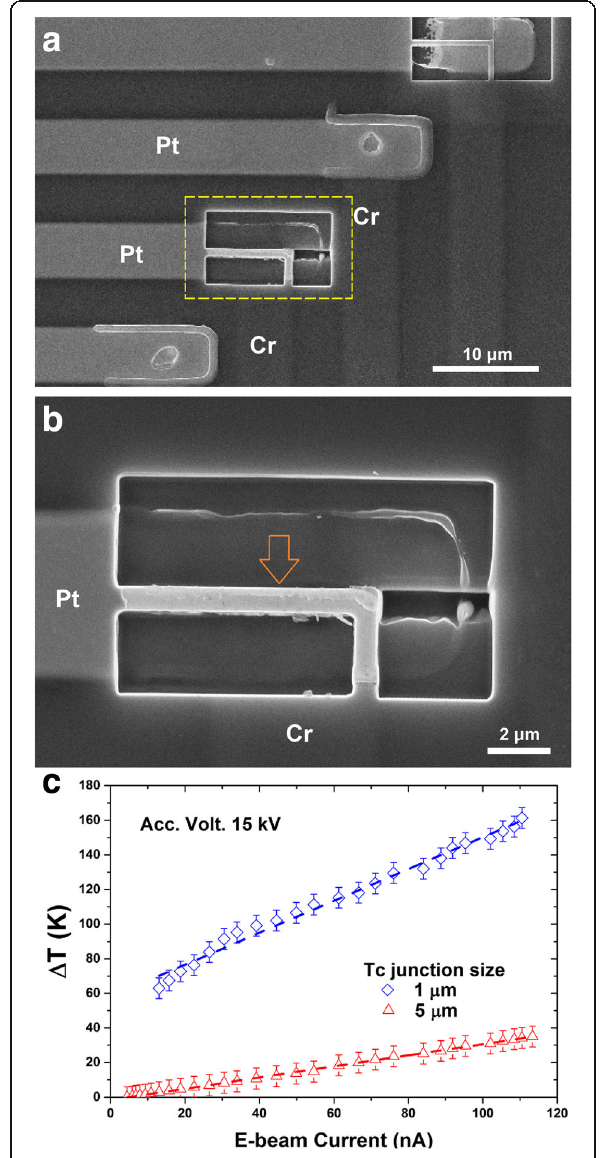
Fig. 7 SEM images of a TFTC array and its measurement results. a SEM image of a Pt-Cr TFTC array on thick Si wafer with identical original junction size of 5.0 × 5.0 μ m 2 . One junction (highlighted with a dashed yellow frame) was cut with FIB to a junction area of 1.0 × 1.0 μ m 2 . b SEM image of the FIB fabricated junction area in ( a ). c Measured outputs from an original TFTC and the small junction TFTC under the same e-beam irradiation